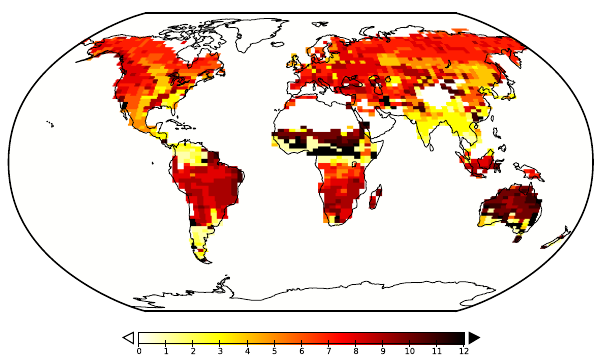
Figure 1. “Fire cells” used in the fire simulations. Numbers from 1 to 12 give the month of the year when fire occurs, whereas 0 corre- sponds to grid cells without